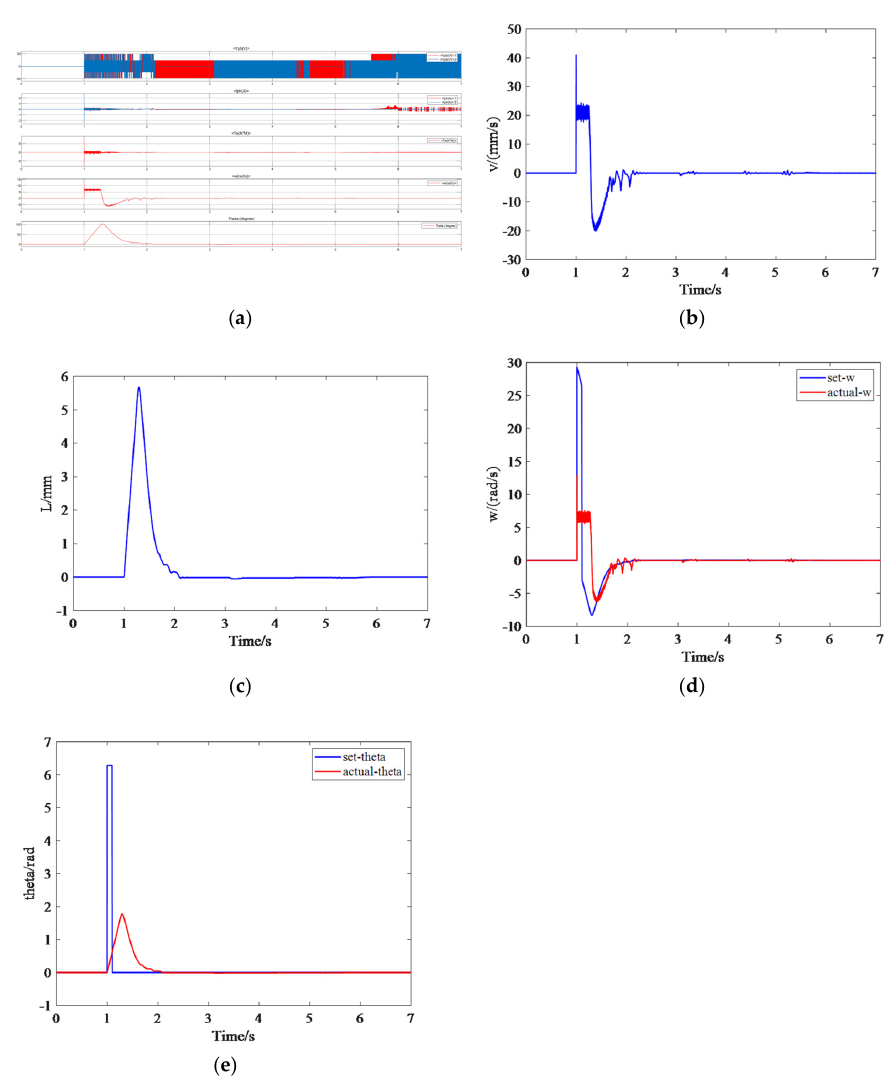
Figure 9. The simulation results of stepper motor with sudden over-groove in smooth condition under incremental PID control strategy for automatic control system of cutter height off the ground. ( a ) The simulation results of stepper motor voltage, current, electromagnetic torque, rotation speed, and rotation angle with sudden over-groove in smooth condition under incremental PID control strategy for automatic control system of cutter height off the ground; ( b ) the simulation results of stepper motor rotation speed (mm/s) with sudden over-groove in smooth condition under incremental PID control strategy for automatic control system of cutter height off the ground when the pitch of ball screw device is 20 mm; ( c ) the simulation results of stepper motor rotation distance (mm) with sudden over-groove in smooth condition under incremental PID control strategy for automatic control system of cutter height off the ground when the pitch of ball screw device is 20 mm; ( d ) the simulation results of stepper motor setting rotation speed and actual rotation speed with sudden over-groove in smooth condition under incremental PID control strategy for automatic control system of cutter height off the ground; ( e ) the simulation results of stepper motor setting rotation angle and actual rotation angle with sudden over-groove in smooth condition under incremental PID control strategy for automatic control system of cutter height off the